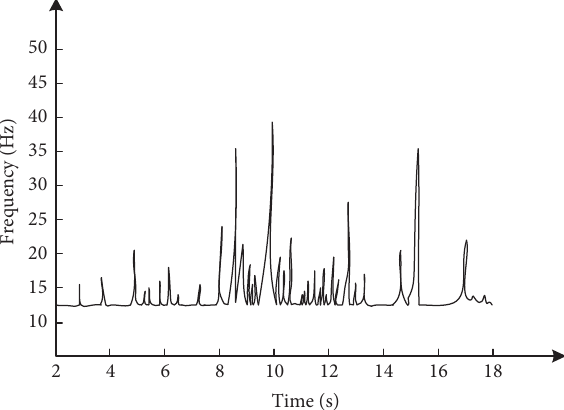
Figure 1: Improved decision tree model of intelligent medical auxiliary diagnosis.